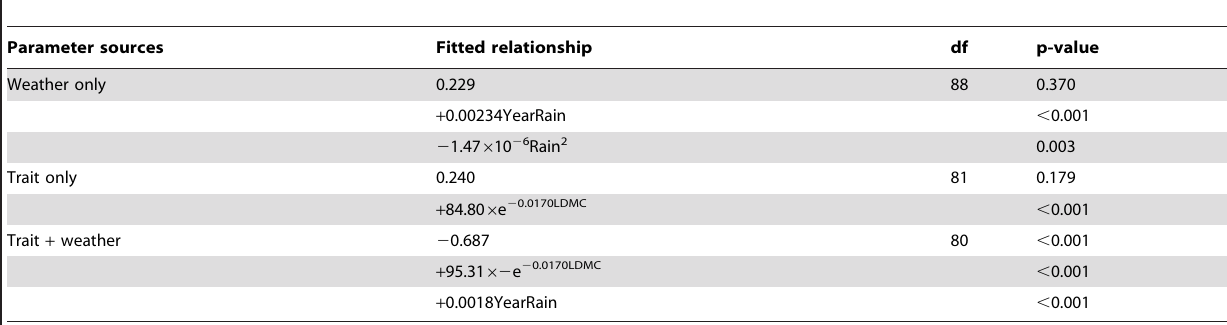
Table 2. Model parameters, parameter probabilities and model fits for the best models containing weather variables, trait variables and the combined models of traits and